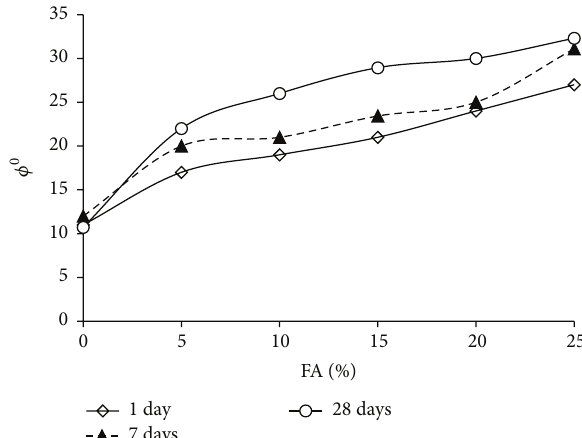
Figure 12: Variation of 𝜙 0 with FA content and curing time.